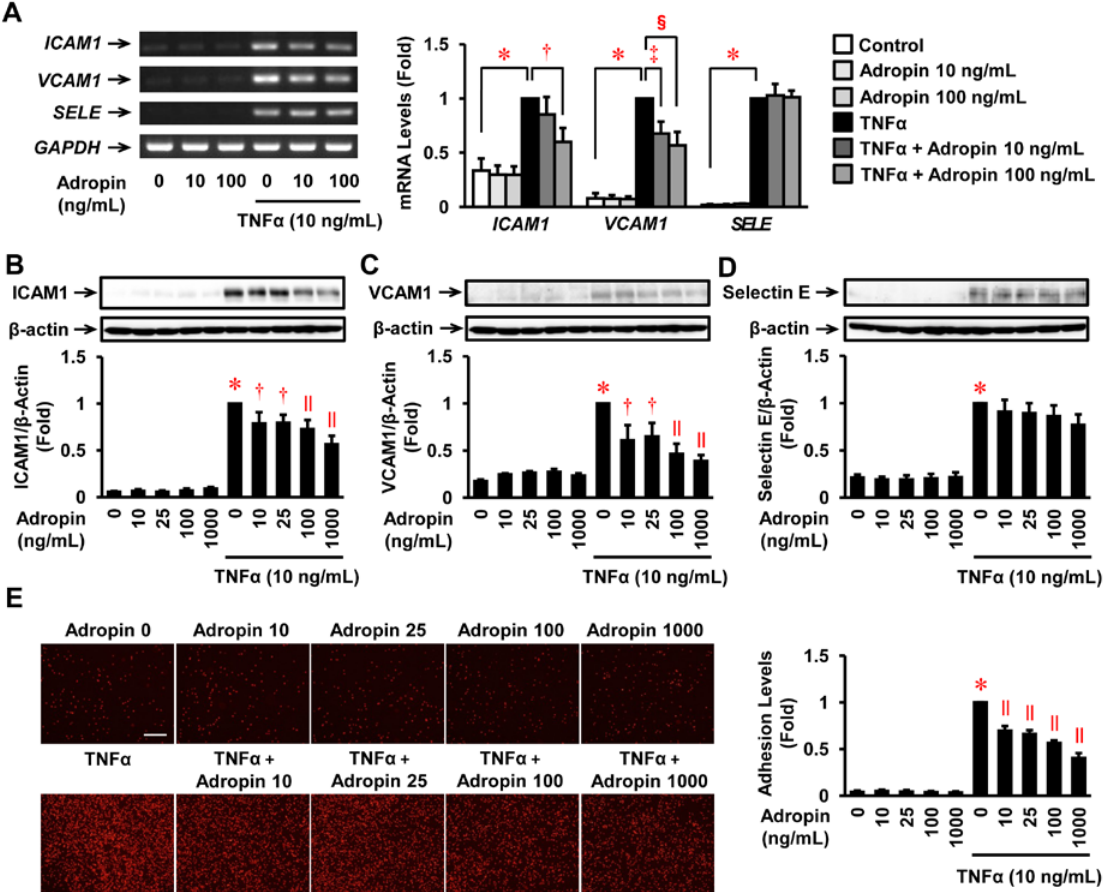
Figure 3. Effects of adropin on inflammatory response and monocyte adhesion in HUVECs. ( A ) mRNA expression of ICAM1 , VCAM1 , and SELE (selectin E gene) was analyzed by RT-PCR.